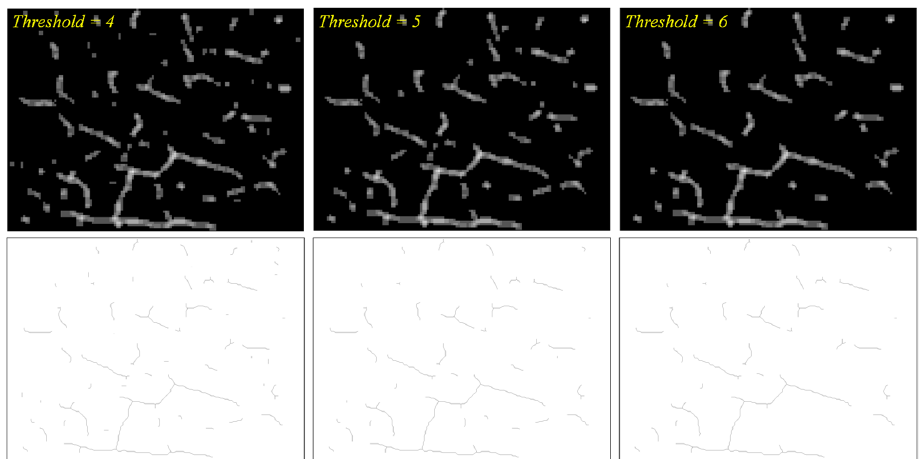
Figure 7. (1st row) Results of filtering pixels and blobs with varied thresholds; (2nd row) results of thinning blobs.